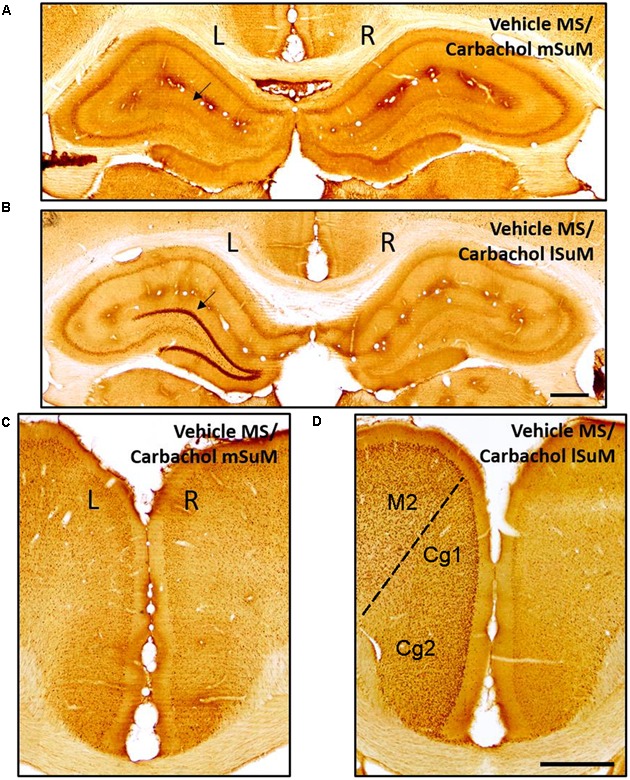
c-Fos protein is induced in the hippocampus and cingulate cortex (Cg) on microinjection of carbachol into the lSuM nucleus. Digital images showing c-Fos-like immunoreactivity (c-Fos-ir) in coronal sections taken through the hippocampus (A,B; posterior ∼2.76 mm from Bregma) and the Cg (Cg1 and Cg2; C,D; anterior ∼2.28 mm from Bregma). c-Fos-ir neurons appear as darkly stained against the background. Note that microinjection of carbachol into left lSuM (B,D; see Figure 1) but not the left mSuM (A,C; see Figure 1) induced c-Fos-ir on the ipsilateral (left, L on figure) but not the contralateral (right, R on the figure) hippocampus and Cg. The c-Fos-ir is particularly evident in the granule cell layer of the dentate gyrus (arrow in B) and Cg at the selected magnification (scale bar represents 100 μm). Besides Cg, an induction of c-Fos is also observed in other regions of the ipsilateral cortex such as the secondary motor cortex (M2), which is shown in (D).